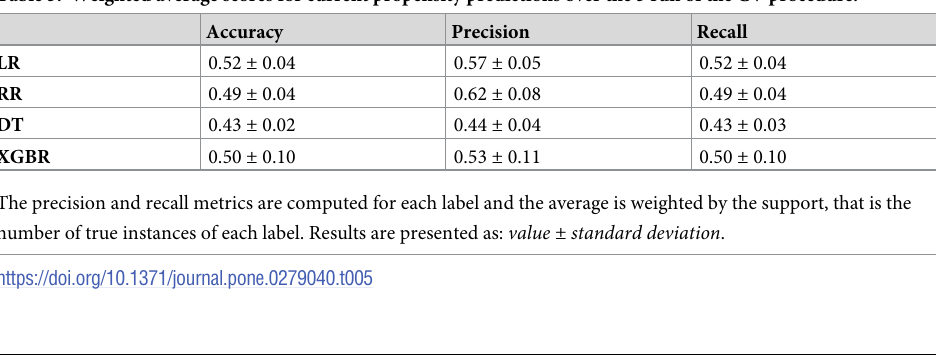
Table 5. Weighted average scores for current propensity predictions over the 3 run of the CV